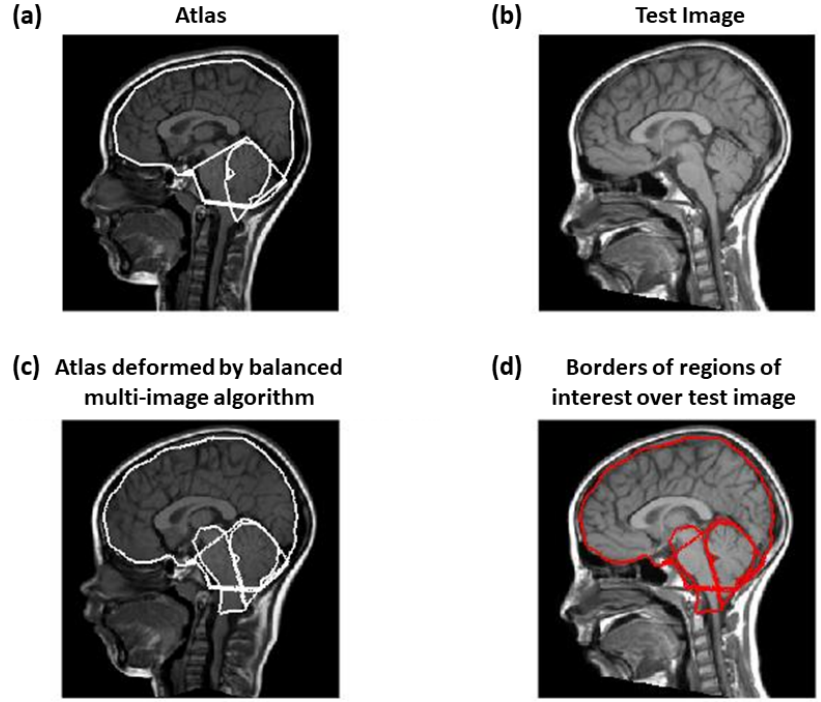
Figure 4. Example of test image registration. The atlas ( a ) and the test ( b ) images are deformed so as to be similar. In the balanced method, both images are iteratively deformed, each by a transformation: by composing the transformation of the atlas and the inverse of the transformation of the test image, the total deformation of the atlas ( c ) needed to make it match the test image is obtained. The deformation is then applied to the regions delineated on the atlas to estimate the corresponding regions for the test MRI ( d